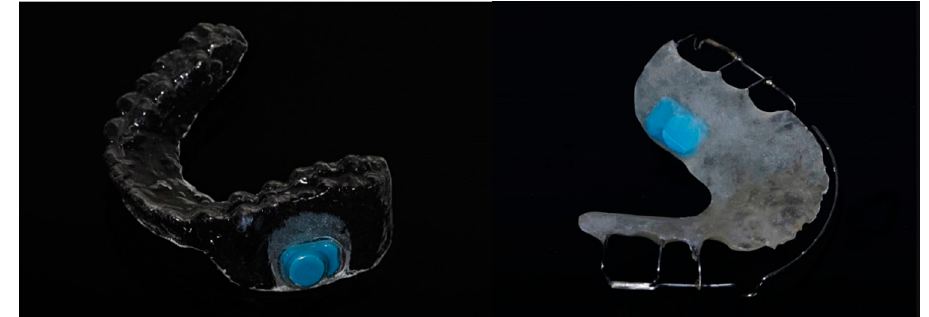
Figure 1. VFM and HR appliances with embedded thermal